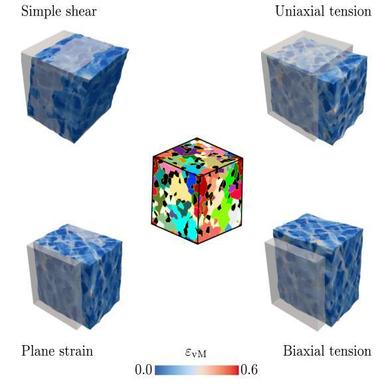
Equivalent strain distributions after different deformation modes in a Dual Phase (DP) steel microstructure. In the central image, which shows the undeformed volume element, colors indicate the crystallographic orientation of the ferritic grains except for the black regions which indicate martensitic grains. (For interpretation of the references to color in this figure, the reader is referred to the web version of this article.)